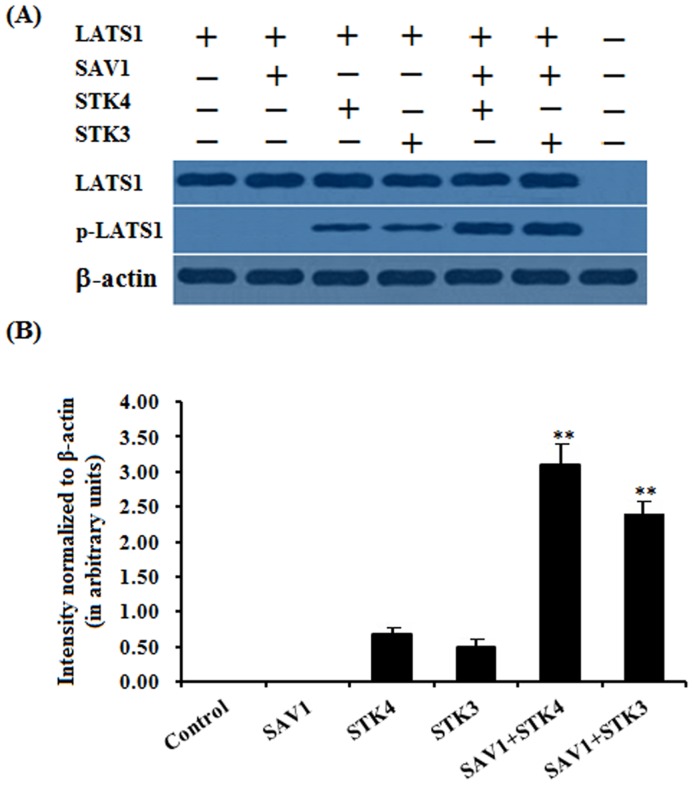
Phosphorylation of LATS1 by SAV1 in vitro.(A) CHO cells (which do not express endogenous chicken LATS1) was transfected with the pCMV-HA-LATS1 expression construct or an empty pCMV-HA vector for 24 h and lysed, cell lysates were immunoprecipitated using an antibody to HA. The immunoprecipitates were analyzed by western blotting with the LATS1 antibody, and the purified LATS1 protein was then used as a substrate to be incubated with the lysates from the cells transfected with the pFLAG-SAV1 construct or an empty pFLAG-CMV-2 vector alone, or co-transfected with the the pcDNA3-STK4 or STK3 expression vector aforementioned for an in vitro phosphorylation assay. The β-actin was used as the loading control. (B) Blotting signal intensity was quantified densitometrically after phosphorimaging (shown in A), and normalized for loading by comparison to the signal for β-actin. The signal intensity of LATS1 or phosphorylated LATS1 was expressed as the ratio β-actin signal in arbitrary units shown in B (n = 5 per mean ± SEM). The Five independent experiments were carried out in triplicate. The results are representative of at least three independent experiments. Statistical significance was marked with different superscript symbols ** P<0.01,* P<0.05.